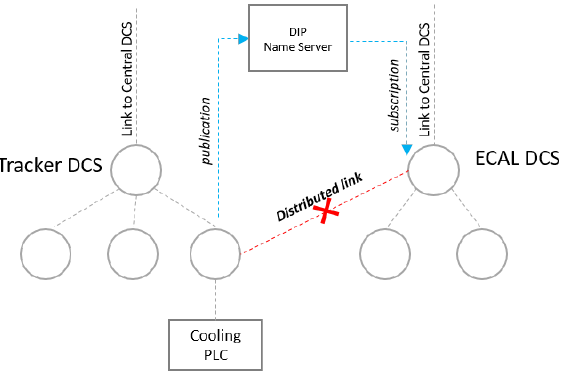
Fig. 3. Replacement of a distributed link by DIP publications, between the ECAL and Tracker